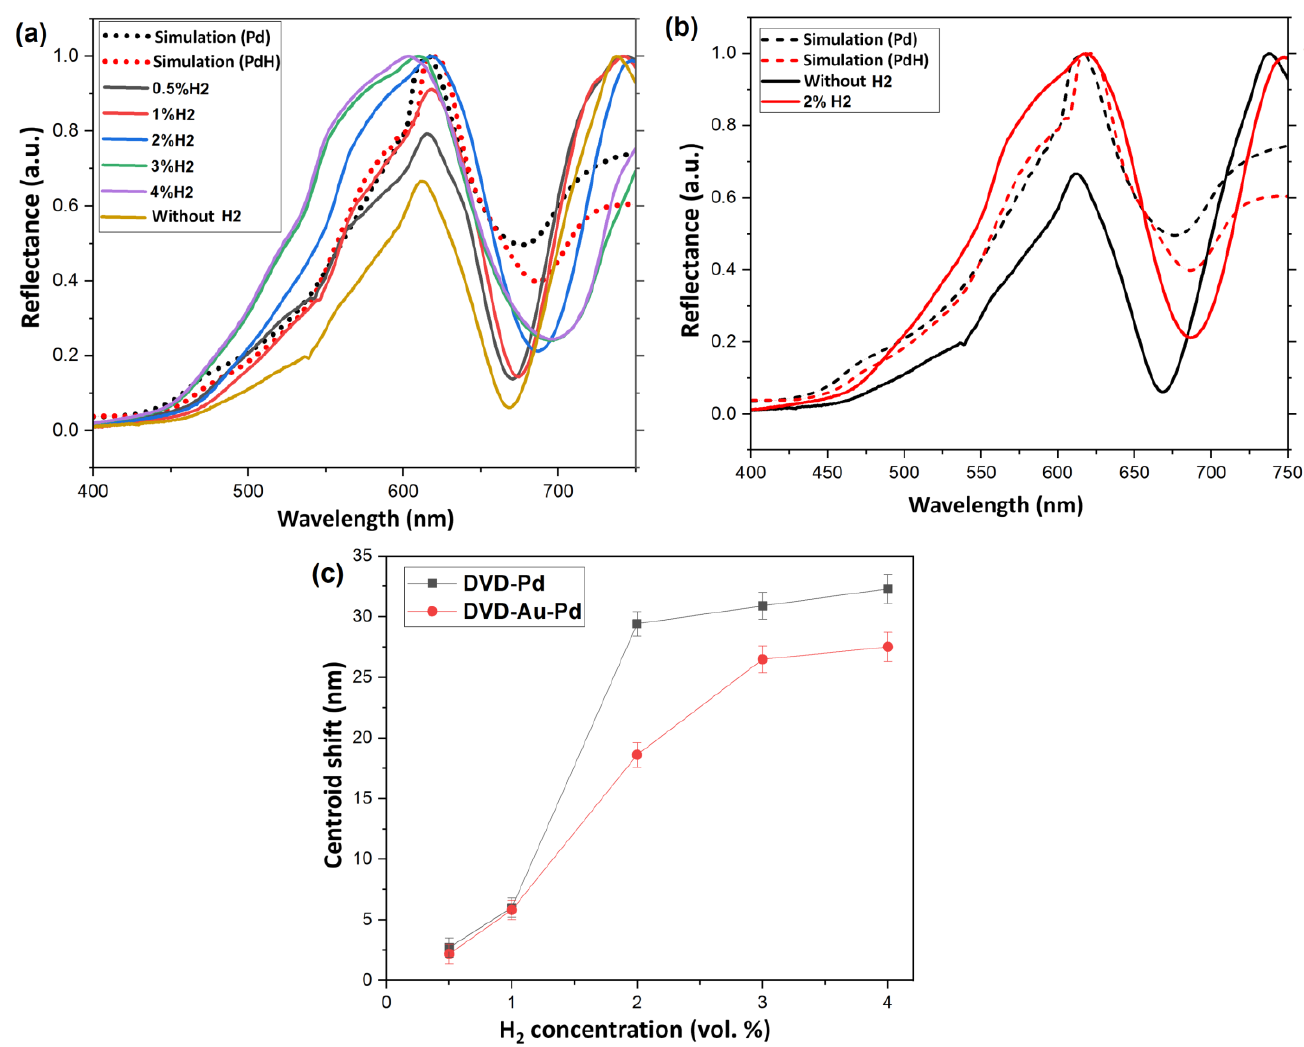
Figure 2. Optical measurements from the nano-grating/Au/Pd structure prototype. ( a ) FDTD simulations and experimental reflectance spectra without or with hydrogen gas exposure at different concentrations (0 to 4 vol.%). ( b ) Theoretical and experimental reflectance spectra in the presence or absence of hydrogen gas. ( c ) Centroid wavelength shift resulting from hydrogen adsorption with respect to volumetric concentration, with a measurement relative error estimated at ± 0.8 nm. Data from the nano-grating/Pd structure are also included for comparison. The incidence angle was 44°.